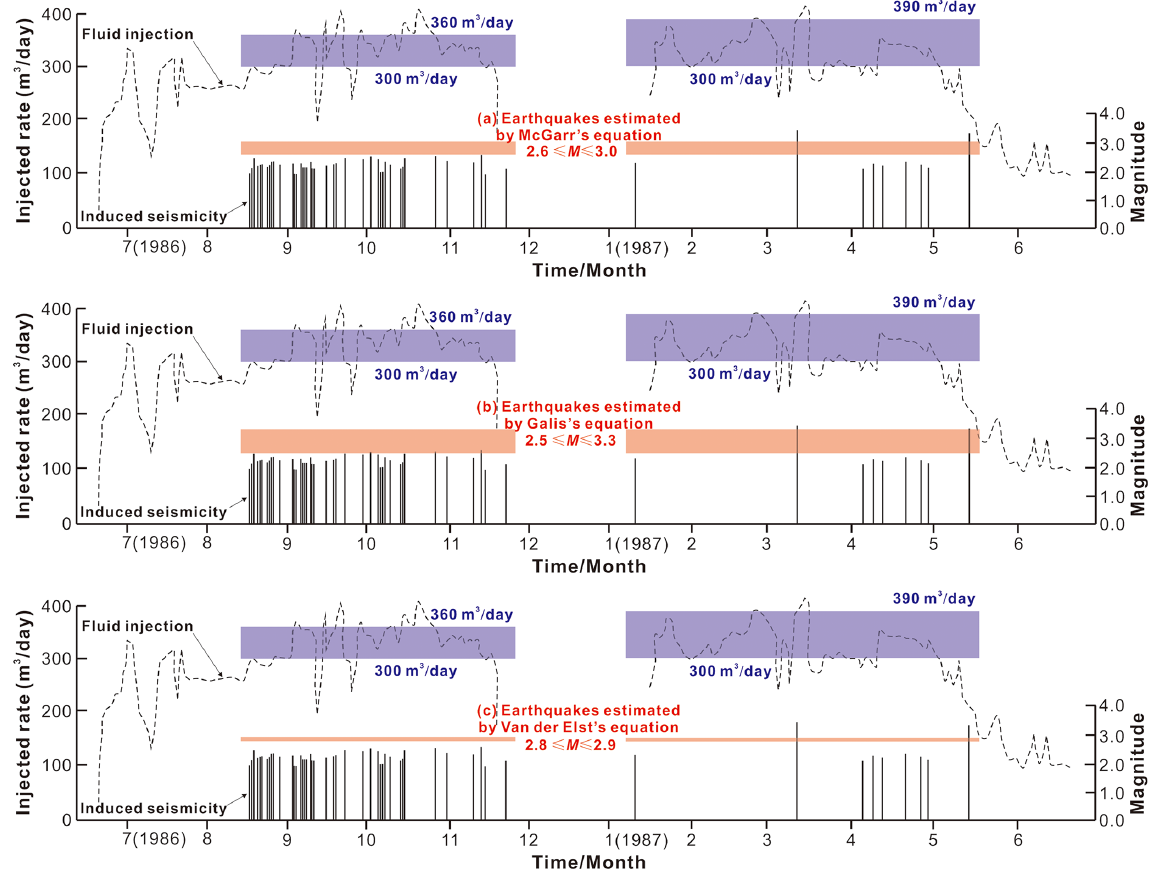
Figure 18. Comparisons of the magnitudes of the injection-induced earthquakes between the observations (vertical black lines) (Zhao and Yang, 1990) and the predicted (orange rectangles) results calculated using the McGarr (2014) model (a) , the Galis et al. (2017) model (b) , and the Van der Elst et al. (2016) model (c) in the Renqiu oilfield of North